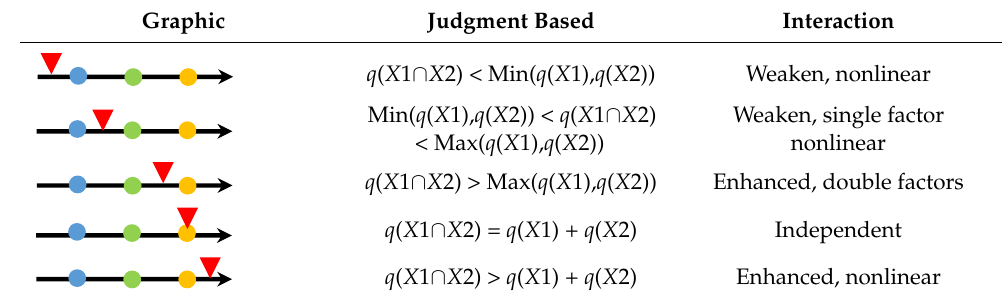
Table 2. Judgment basis of the interaction detector.